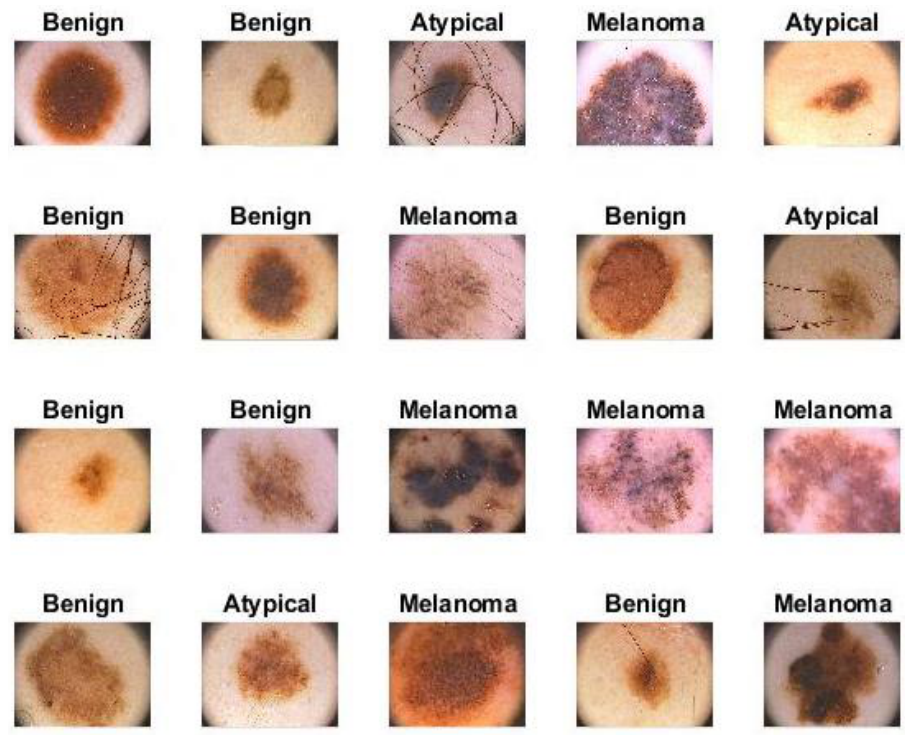
Figure 3. Samples of skin diseases obtained from the PH2 dataset.